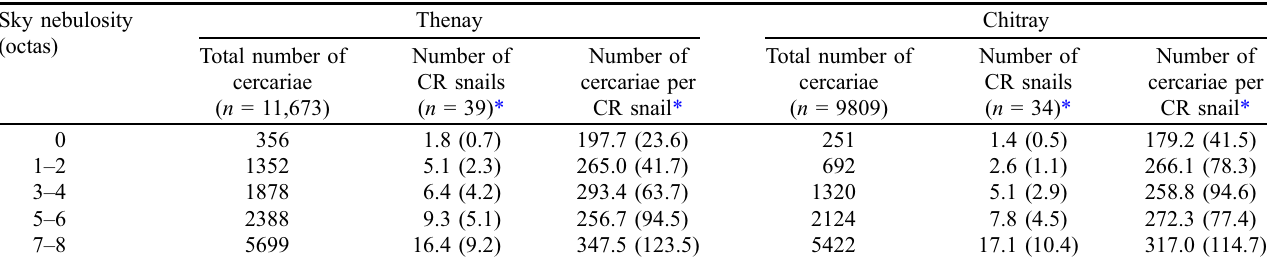
Table 4. Number of cercariae-releasing (CR) snails and number of Fasciola hepatica cercariae in the two temperature-challenged subgroups subjected to natural light during thermal shock (experiment A) in relation to sky nebulosity expressed in 2 octas each.